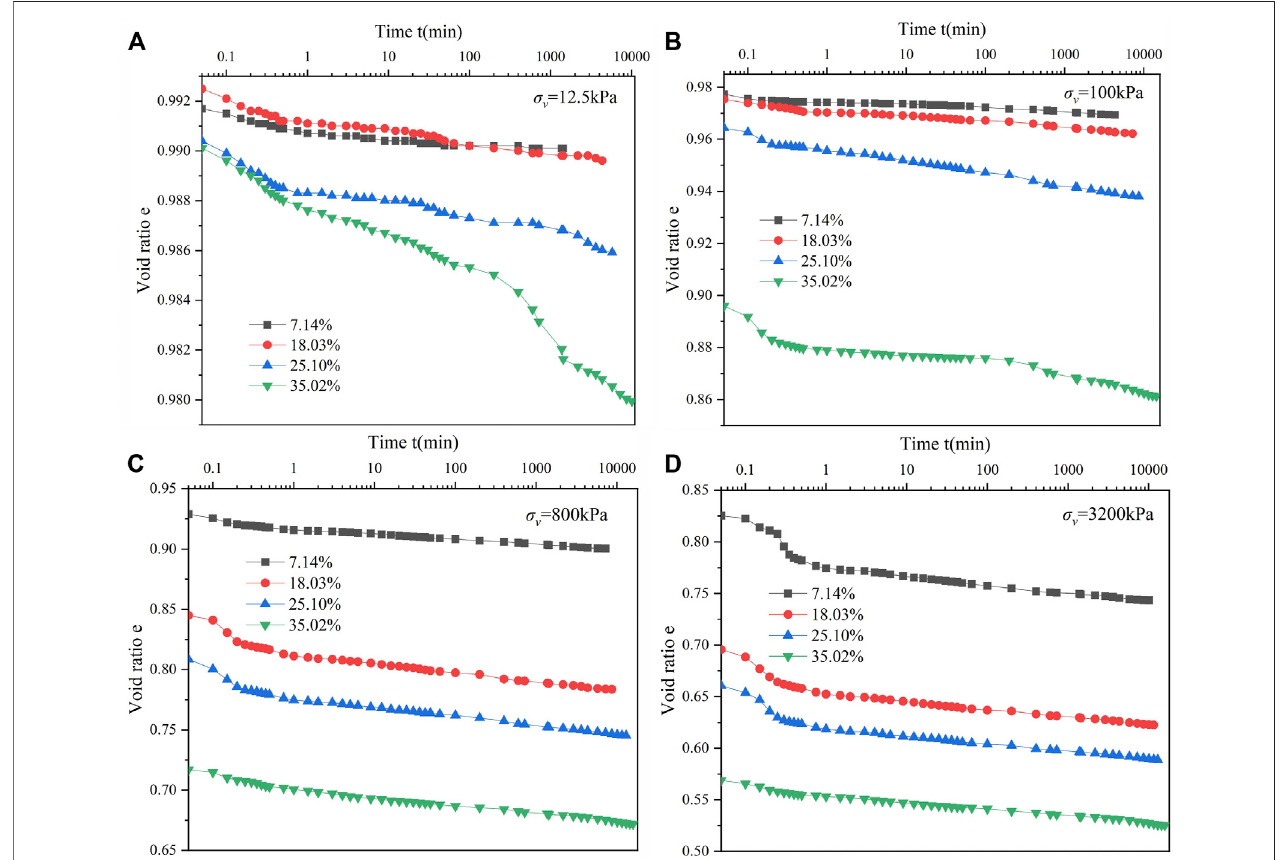
FIGURE 8 | Variation of the void ratio with time for intact loess at different water contents: (A) 12.5 kPa, (B) 100 kPa, (C) 800 kPa, and (D) 3,200 kPa.